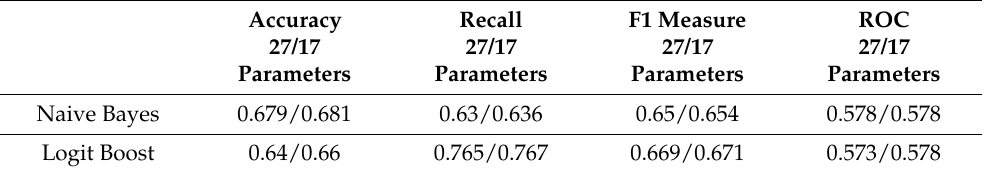
Table 7. Performance indicators obtained by the classification algorithms using 17 parameters.